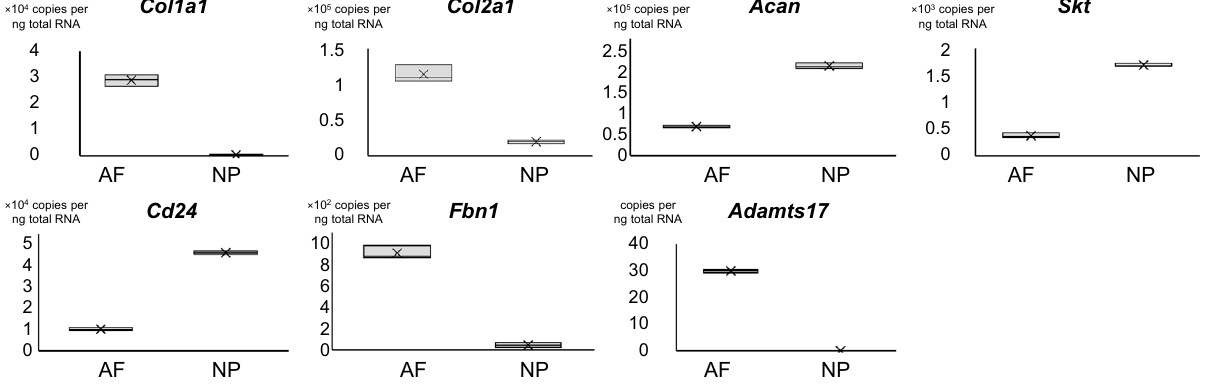
Figure 2. Expression levels of ADAMTS17 and FBN1 in the annulus fibrosus and nucleus pulposus in the mouse intervertebral disc. qRT-PCR revealed the expression of Adamts17 and Fbn1 in the annulus fibrosus (AF) of mouse intervertebral disc. High expression of Col1a1 in AF, and high expression of ACAN , Skt , and CD24 in nucleus pulposus (NP) confirmed the proper separated harvest of AF and NP tissues. Eight lumbar IVDs from two mice were collected to obtain enough tissues. All reactions were performed in